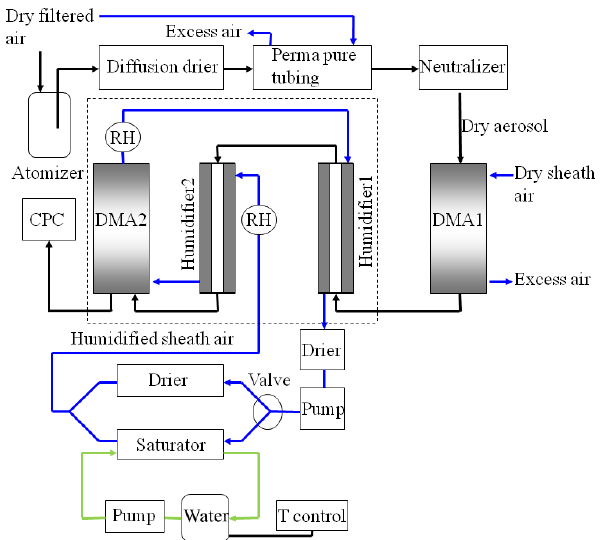
Figure 19. Schematic diagram of a typical H-TDMA instrument. Reprint with permission by Jing et al. (2016).